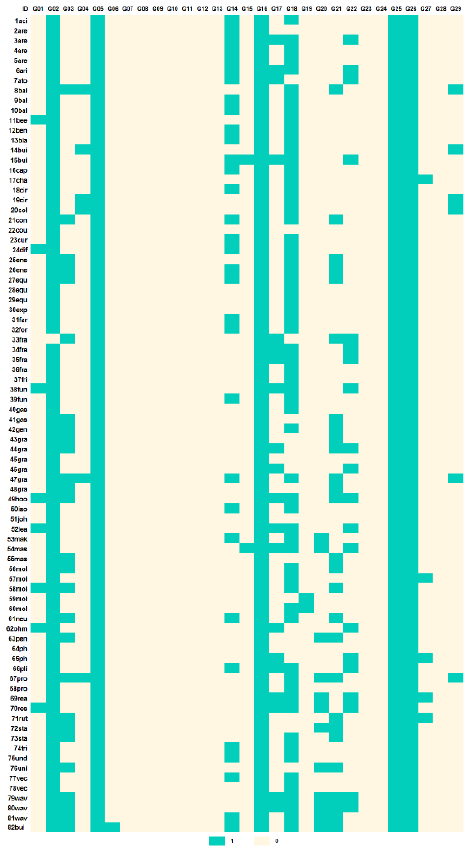
Figure 3. Manual evaluation of serious games.